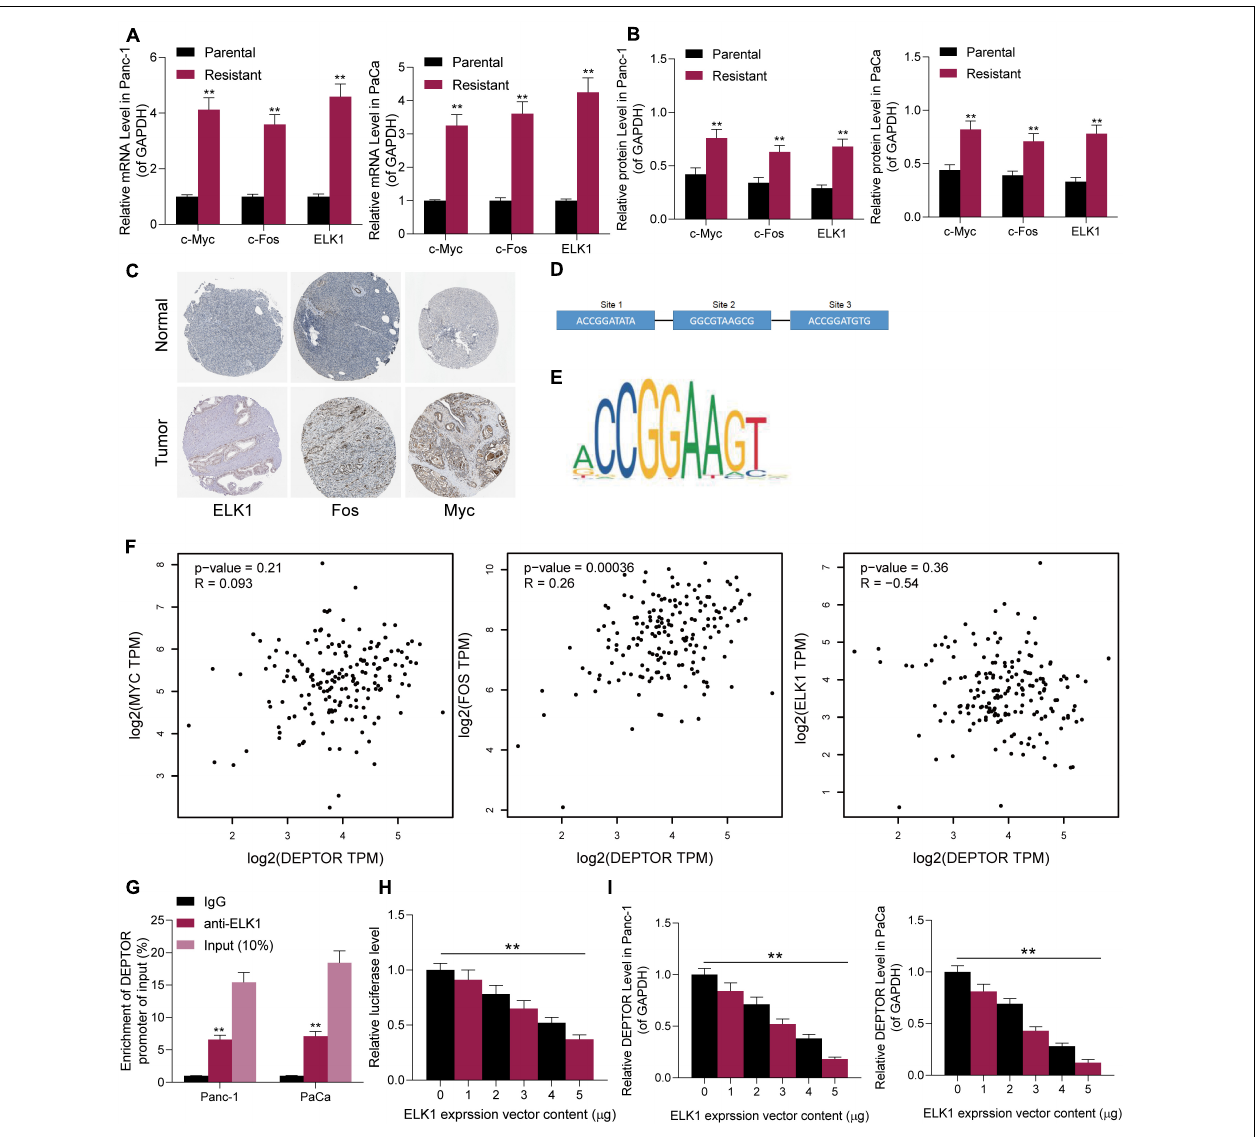
FIGURE 5 | ELK1 is highly expressed in genistein-resistant cells and suppresses DEPTOR transcription. (A,B) mRNA (A) and protein (B) expression of c-Fos, c-Myc, and ELK1 in parental and genistein-resistant Panc-1 and PaCa cells examined by reverse transcription quantitative polymerase chain reaction (RT-qPCR) and Western blot assays, respectively; (C) Staining intensity of c-Fos, c-Myc, and ELK1 in PC tissues predicted on the Human Protein Atlas website. (D) Binding sites between c-Fos/c-Myc/ELK1 and DEPTOR in cells predicted on the JASPAR system. (E) The conservative binding sequence of ELK1. (F) Correlation between the expression of c-Fos/c-Myc/ELK1 and the expression DEPTOR in the TCGA-PAAD database using the GEPIA system. (G,H) Binding relationship between ELK1 and the promoter sequence of DEPTOR validated through ChIP-qPCR (G) and luciferase (H) assays. (I) mRNA expression of DEPTOR in Panc-1 and PaCa cells examined by RT-qPCR. Data were collected from three independent experiments and presented as mean ± SD. ** p <